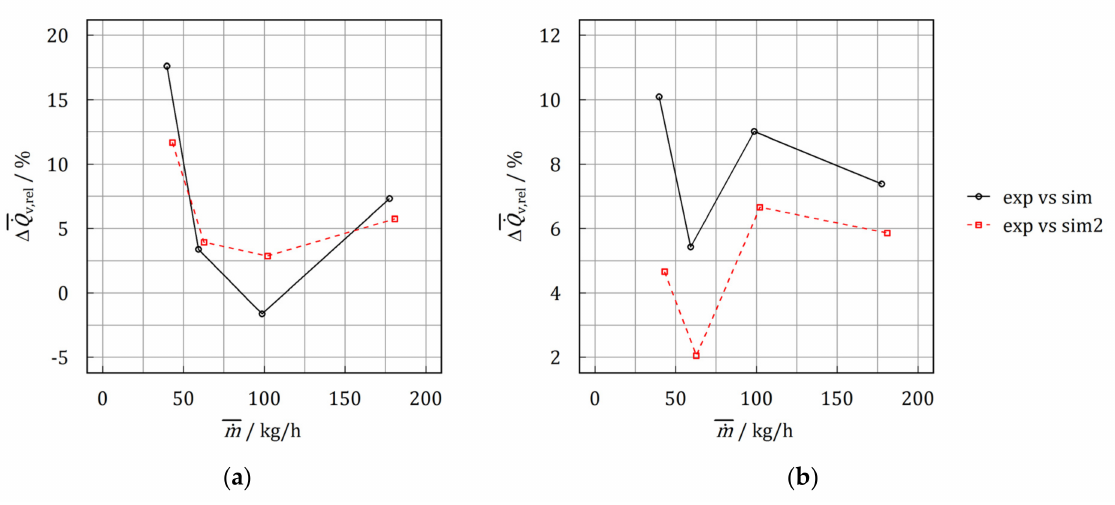
. Q v,rel for crystallization ( a ) and melting ( b ) for the